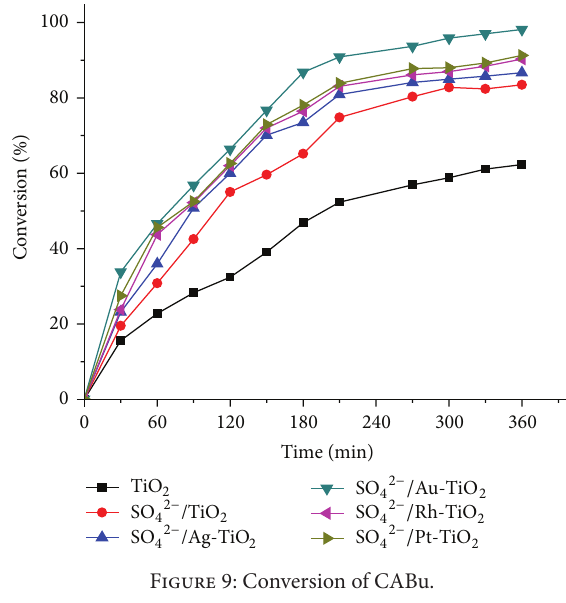
Figure 9: Conversion of CABu.